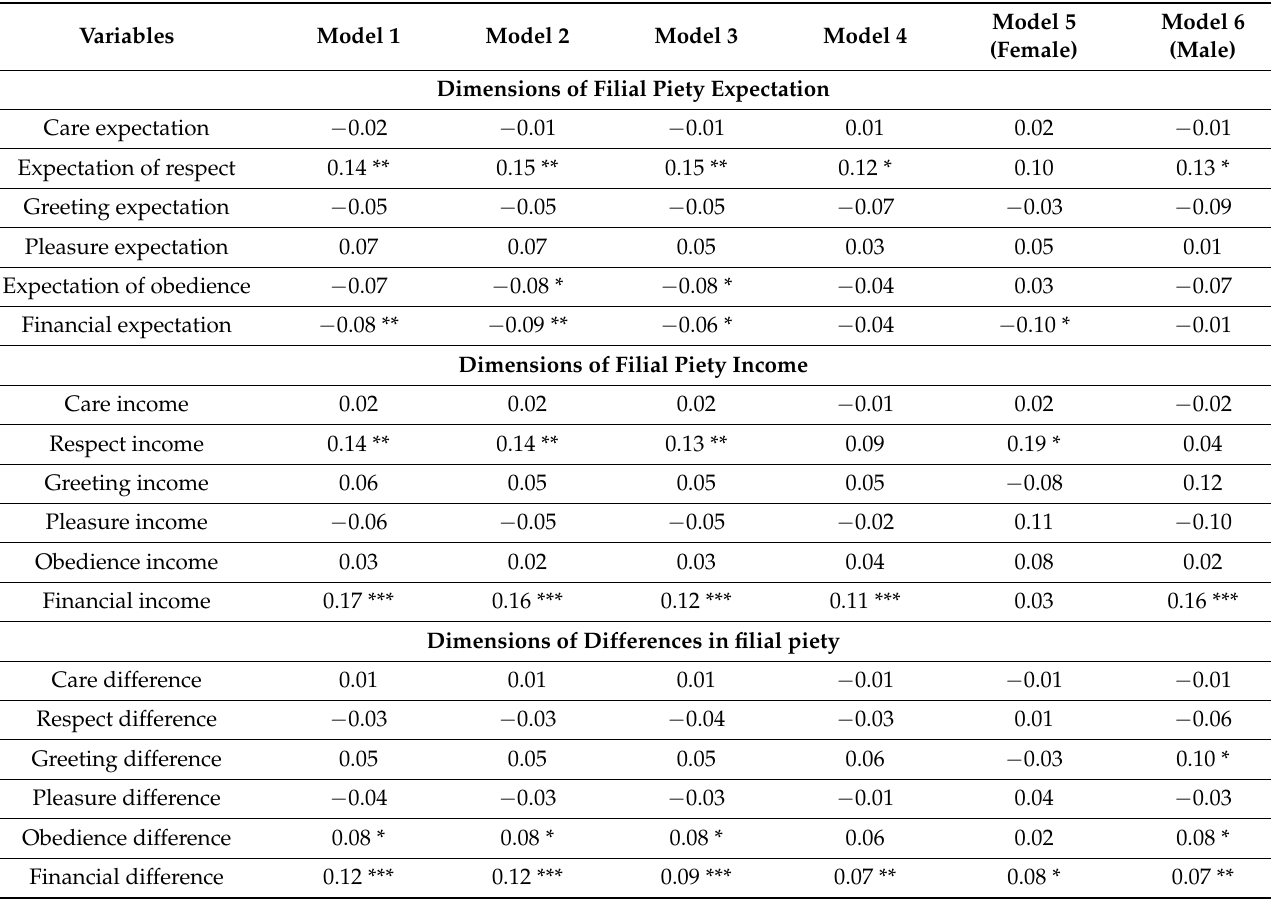
Table 7. Each dimension of filial piety and life